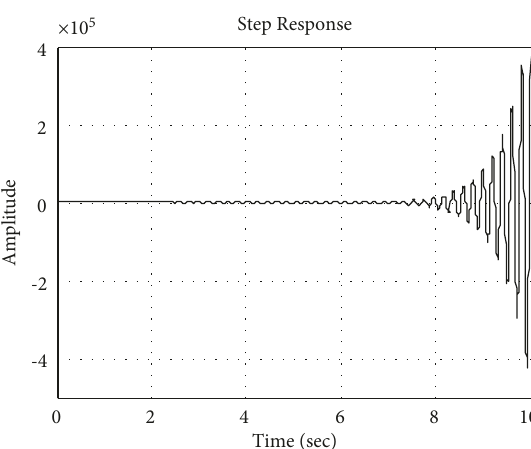
Figure 25: Response curve at 10 times β